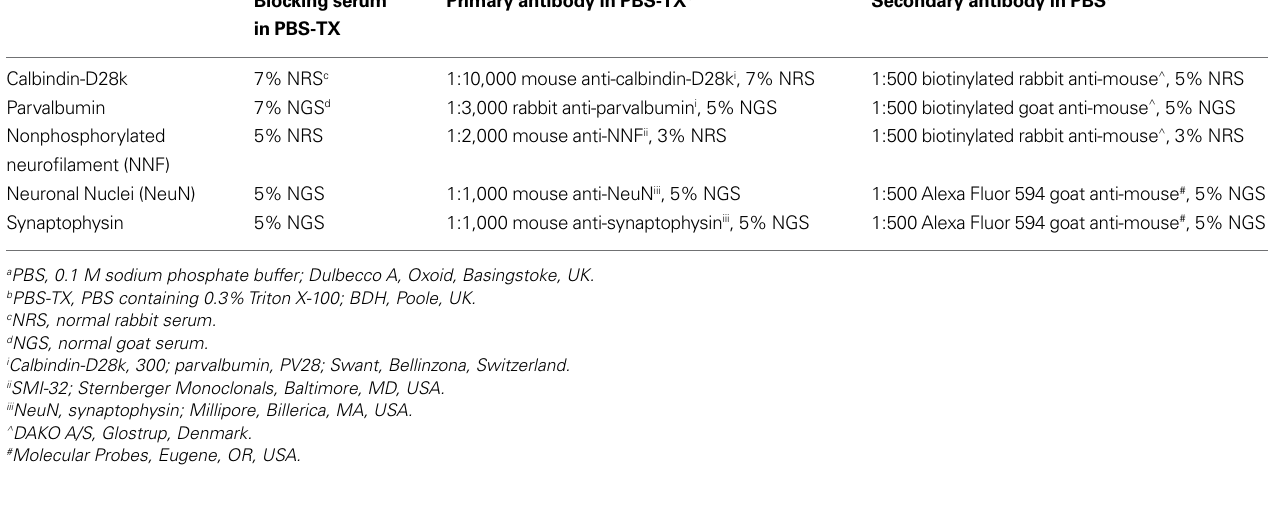
Table 1 | Concentration of blocking solutions, primary antibodies and secondary antibodies used in immunohistochemistry. Blocking